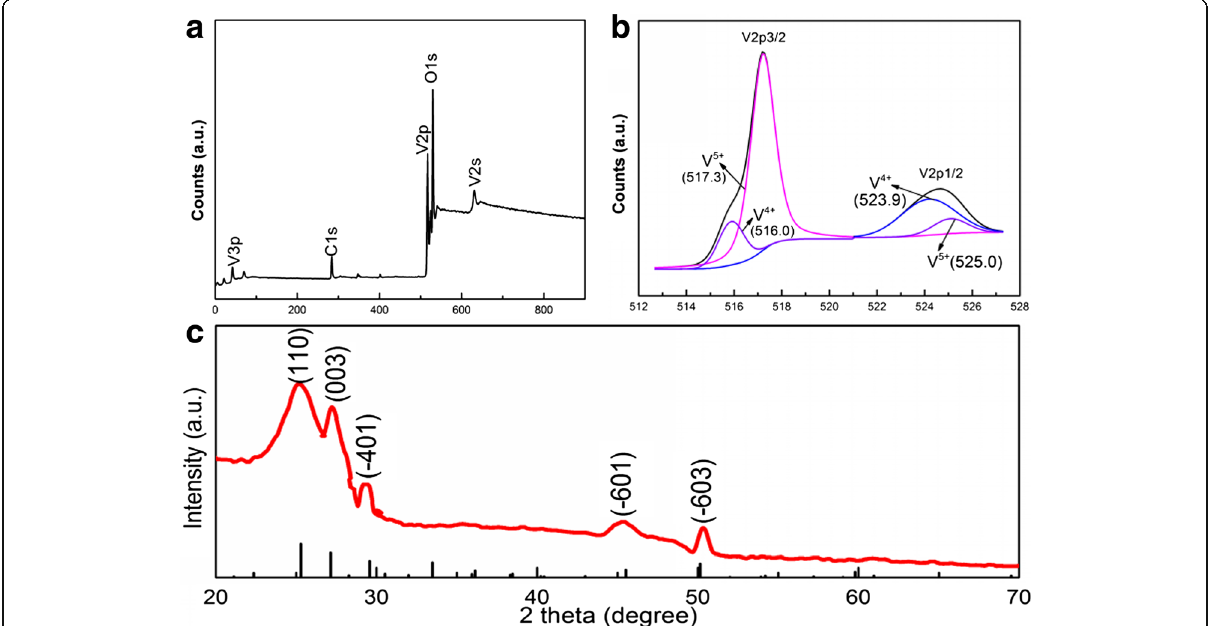
Fig. 3 a A survey XPS spectrum of 3D free-standing interconnected V 6 O 13 nanosheets grown on c-textile. b Spectrum of V 2p and O 1s with a fitted curve. c The XRD patterns of V 6 O